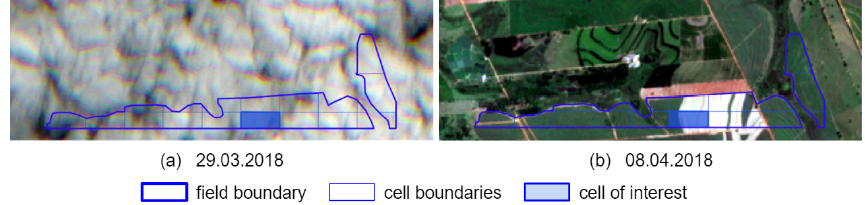
Figure 15. ( a , b ) Example of the cloudiness effect during the harvest period